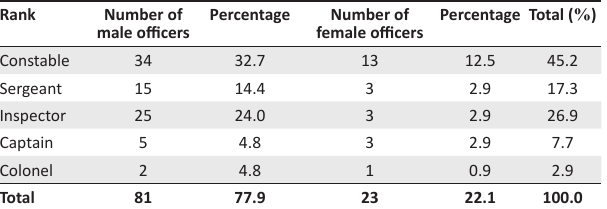
TABLE 2: Gender and rank of respondents.